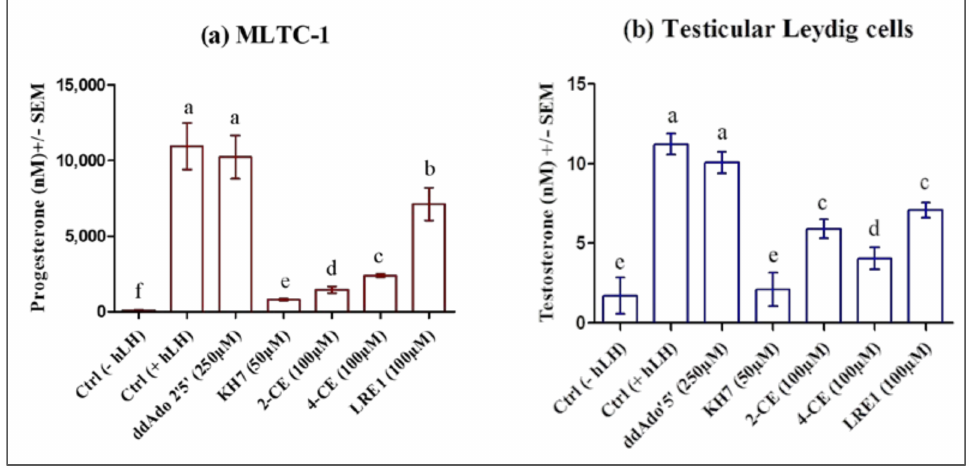
Figure 8. Effect of KH7, 2-CE, 4-CE, LRE1, or ddAdo5 (cid:48) , on 0.7 nM hLH-promoted steroid production in MLTC-1 and primary Leydig cells. ( a ) MLTC-1 cells or ( b ) Testicular Leydig cells were preincubated with or without KH7, 2-CE, 4-CE, LRE1, or ddAdo5 (cid:48) , at the indicated concentrations for 1 h and then the cells were stimulated for 3 hours with 0.7 nM hLH before progesterone ( a ) or testosterone ( b ) productions were measured. Data are means ± SEM of 3 independent experiments performed in duplicate. p value of <0.05 was considered statistically significant using a one-way ANOVA followed by the Dunnett’s test post-test. Different letters indicate significant differences between control (0 µ M) and each treatment at p <